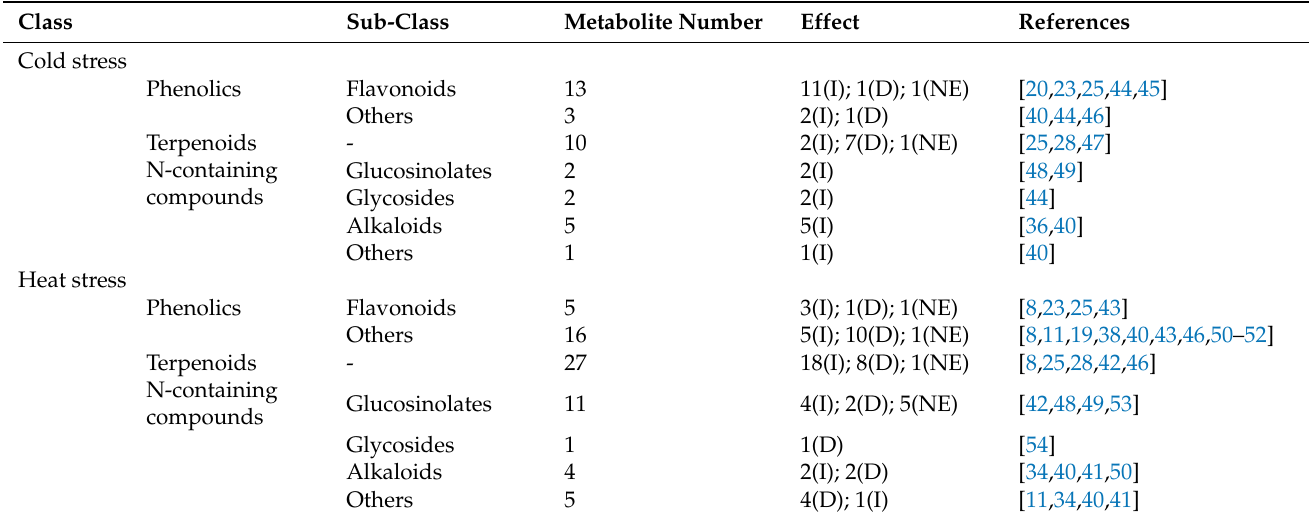
Table 1. Effects of temperature on plant secondary